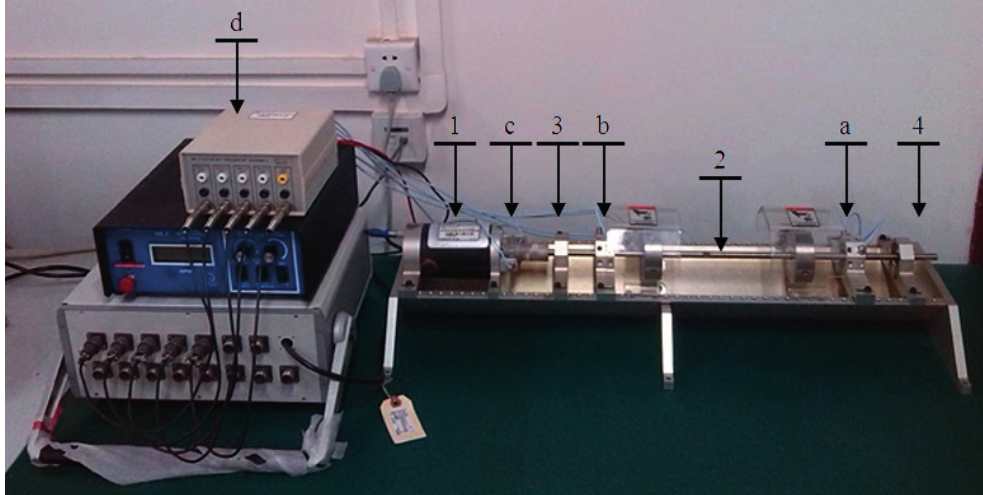
Figure 10. Bently RK4 rotor test bench. 1. motor, 2. rotor, 3. bearing, 4. foundation;